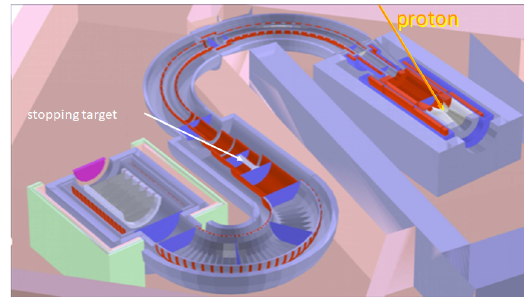
Figure 9: Photograph of the Cylindrical Drift Chamber (CDC) and its trigger sys- tem (prototype) for COMET.